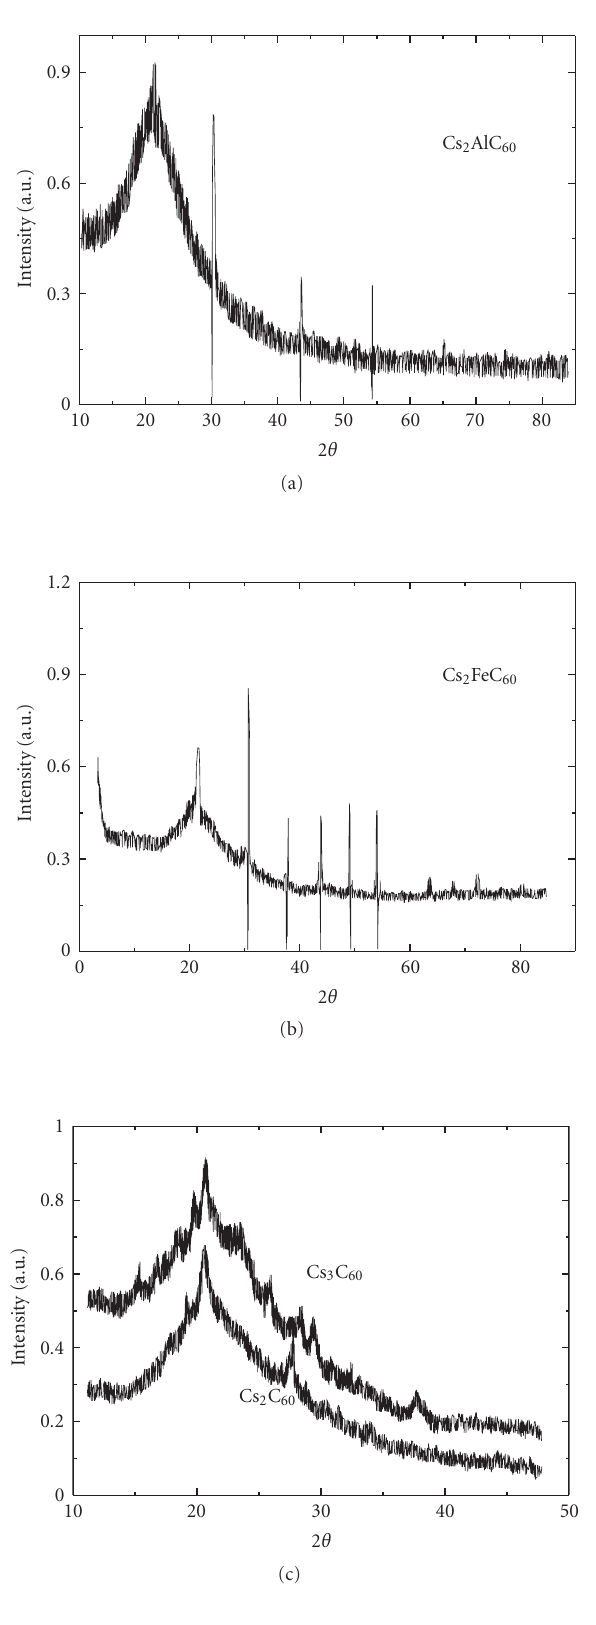
Figure 2: Di ff ractogram of Cs 2 AlC 60 , Cs 2 FeC 60 , and Cs 2 C 60 , Cs 3 C 60 . Vertical lines show peaks of CsCl. There is no reflection from fulleride crystal lattice.